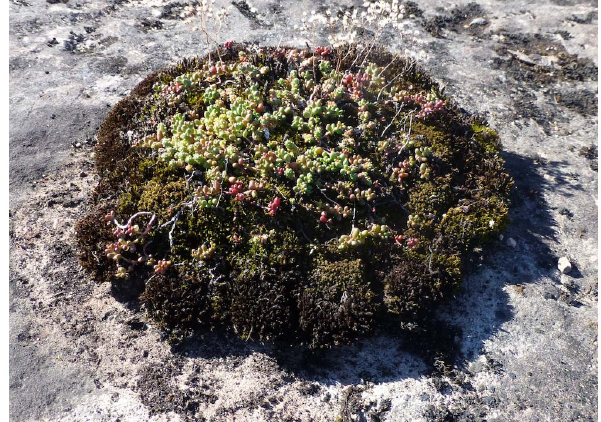
Figure 1. Sedumalbum growing on a moss cushion in an alvar area on O¨ land, SE Sweden. Photo taken in the autumn of 2013.